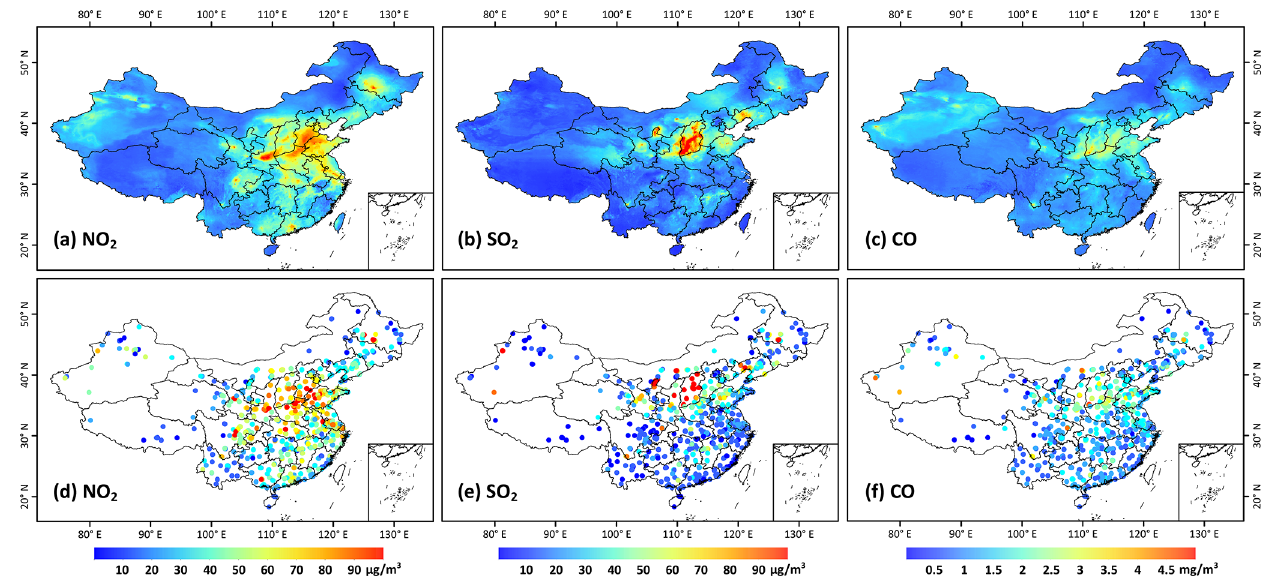
Figure 2. A typical example of (a–c) big-data-derived (horizontal resolution = 10km) seamless surface NO 2 (µgm − 3 ), SO 2 (µgm − 3 ), and CO (mgm − 3 ) concentrations and (d–f) corresponding ground measurements on 1 January 2018 in